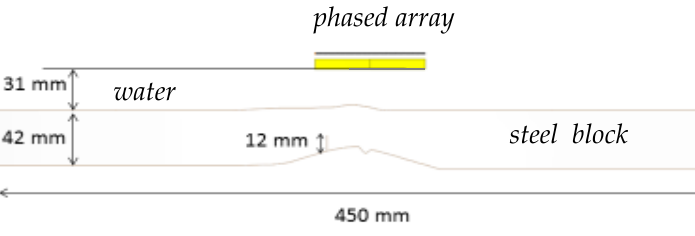
Figure 14. A schematic of the CEA experiment.